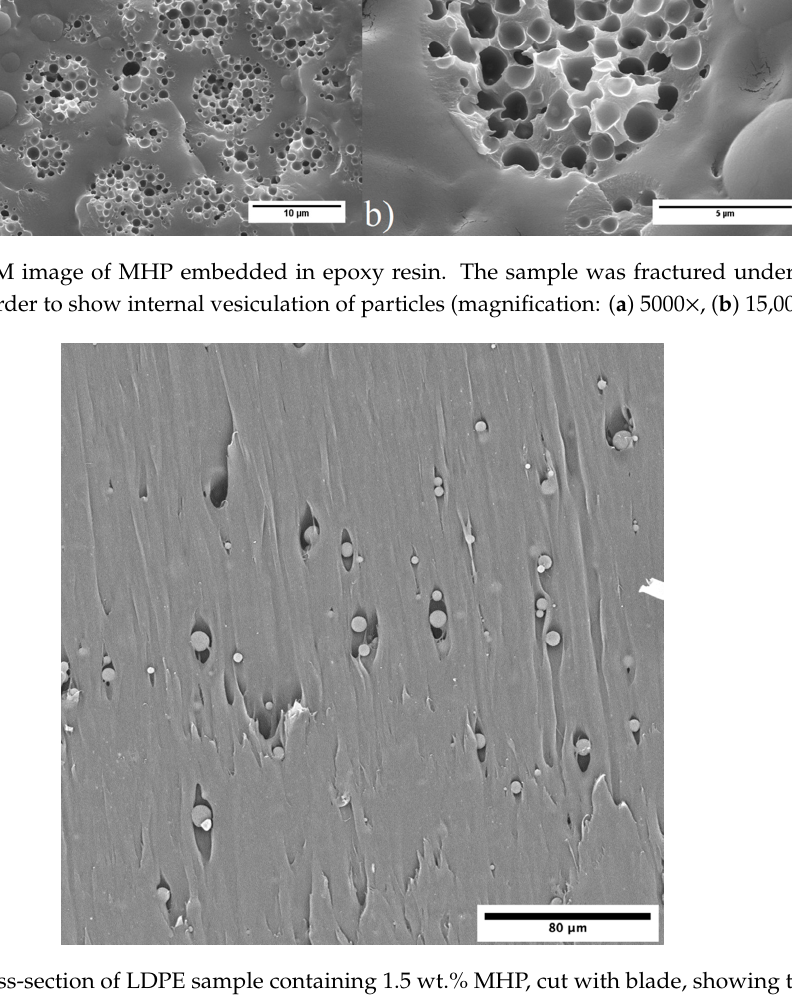
Figure 2. SEM image of MHP embedded in epoxy resin. The sample was fractured under liquid